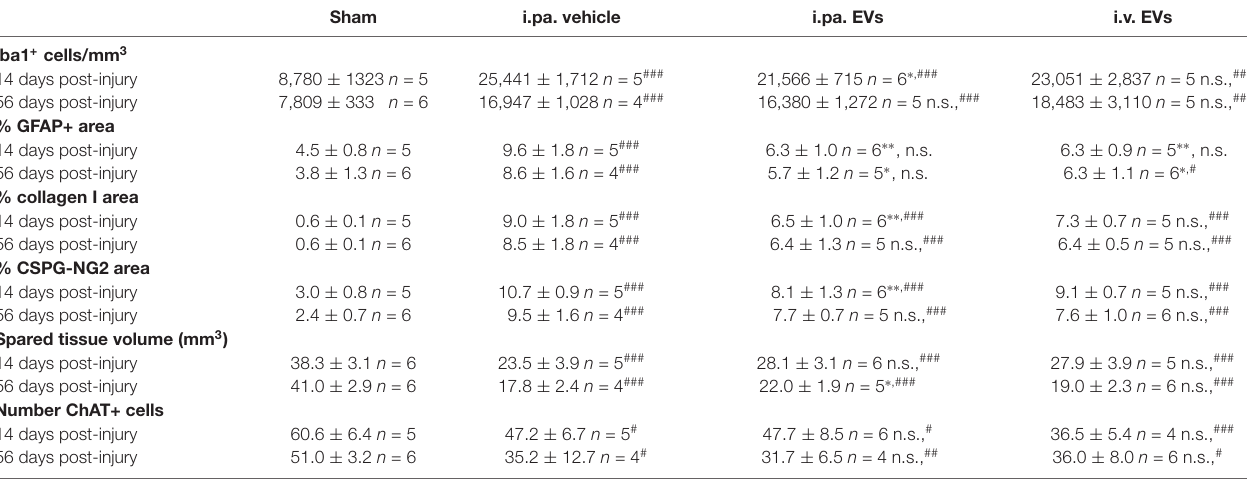
TABLE 2 | Summary of histological